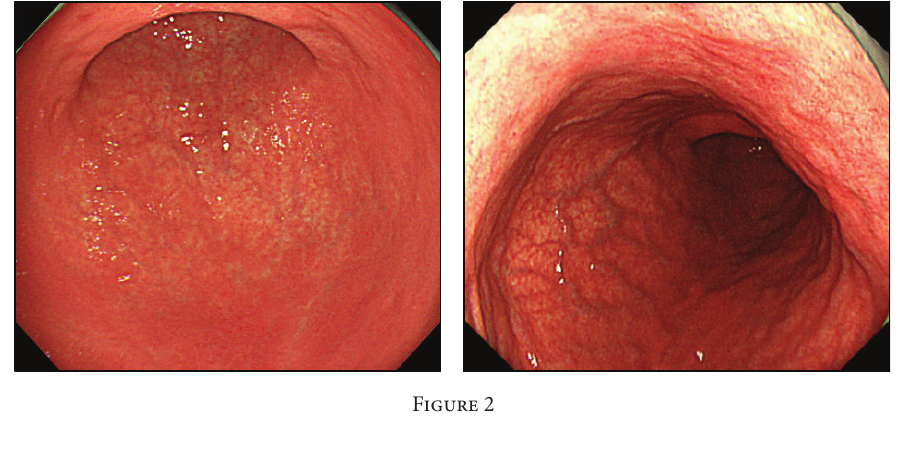
146 gastric neoplasms <Excluded lesions> levels3 patients had a history of partial gastrectomy 41 patients had previously undergone Helicobacter pylori eradication treatment 14 patients had an unclear history of Helicobacter eradication treatment and serum pepsinogen 88 gastric neoplasms adenomas67 early gastric cancers 4 patients had histopathological findings indicating undifferentiated adenocarcinoma 21 gastric or other malignant tumors 63 early gastric cancers